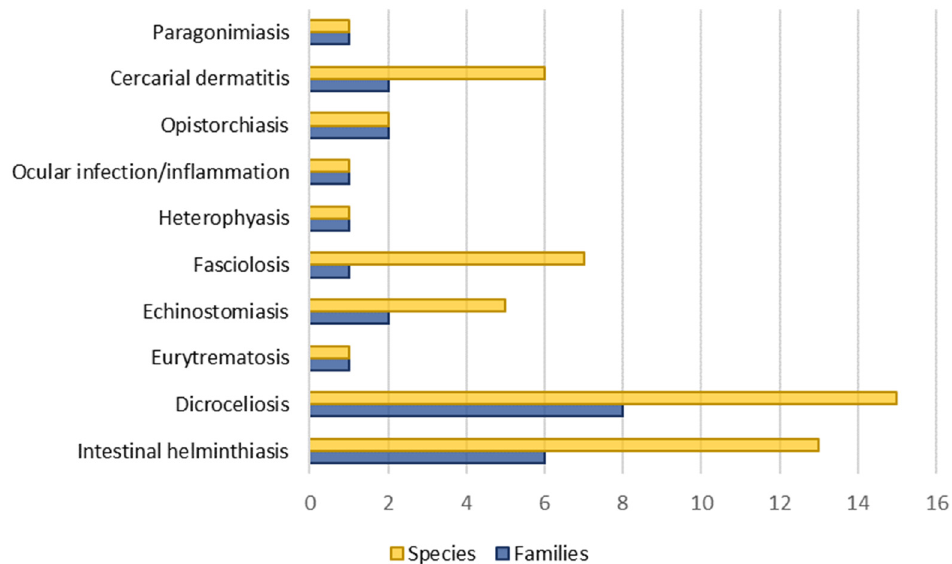
Figure 9. Diversity of species (yellow) and families of molluscs (blue) transmitters of diseases produced by digenean trematodes.